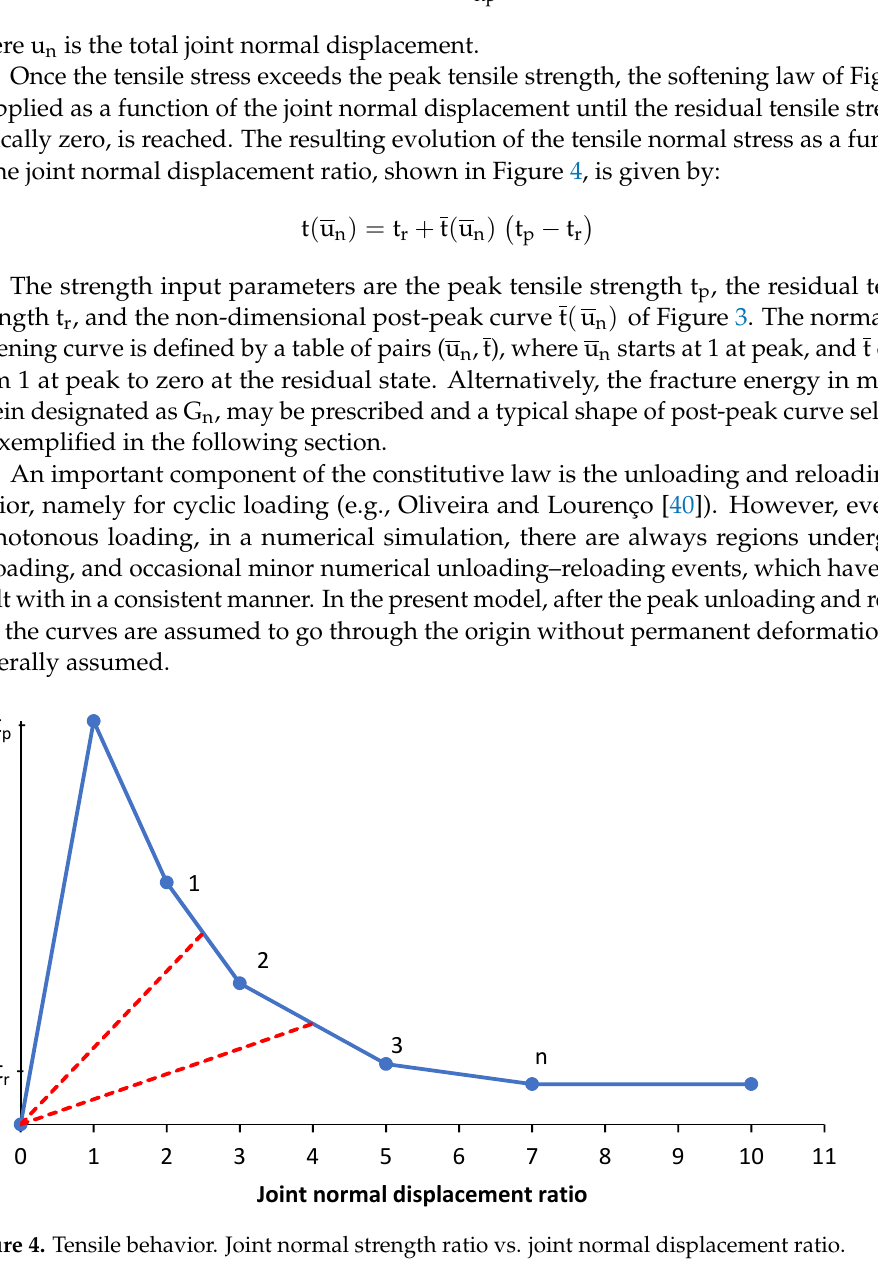
Figure 4. Tensile behavior. Joint normal strength ratio vs. joint normal displacement ratio.